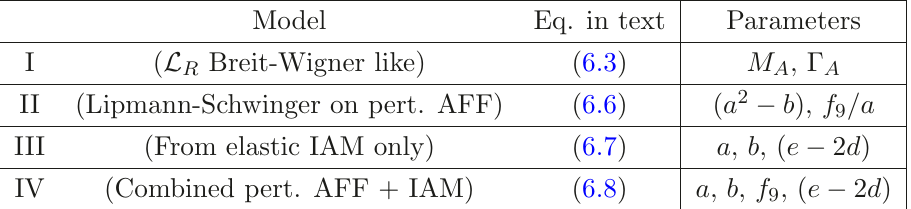
Table 1 . Parameters employed to obtain the axial form factor of a relatively narrow V L h resonance with mass around 3 TeV and width about 0.5 TeV, plotted in figure